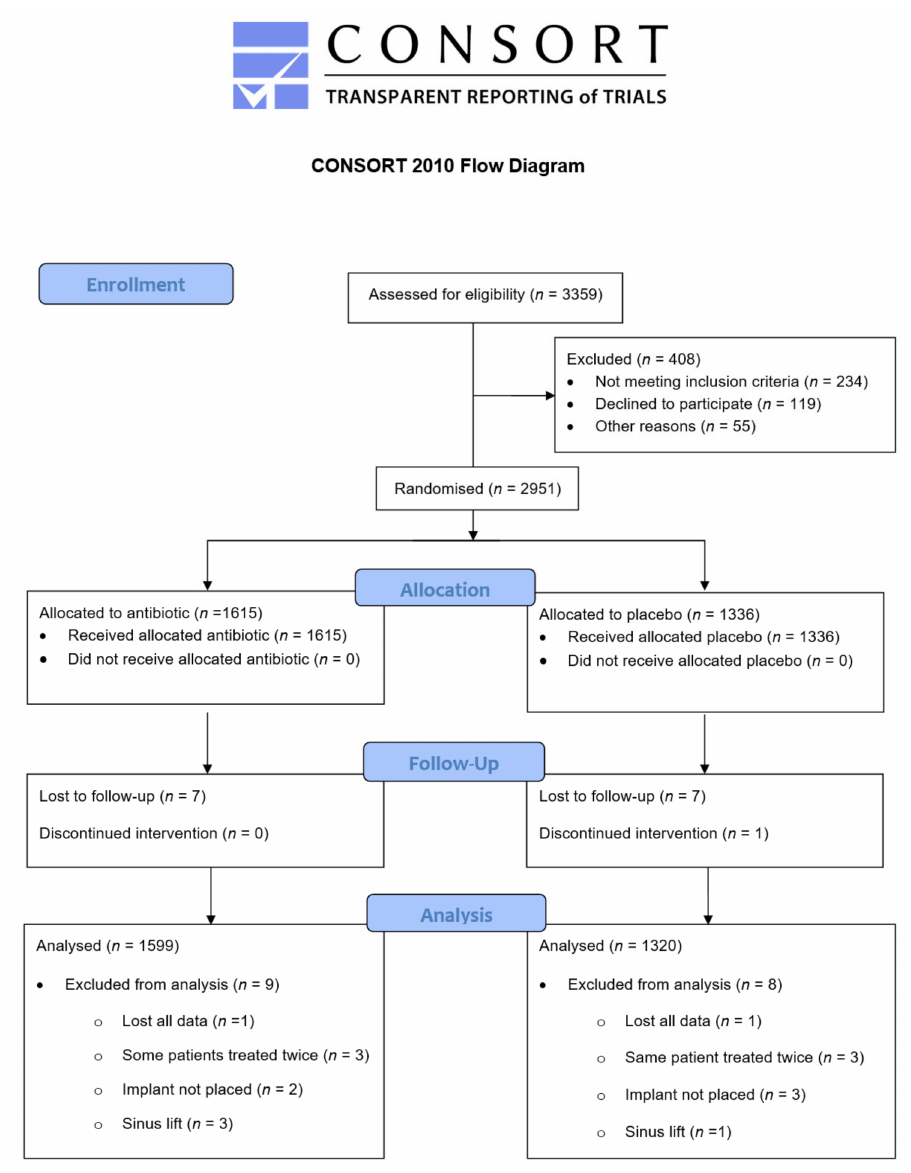
Figure 2. CONSORT